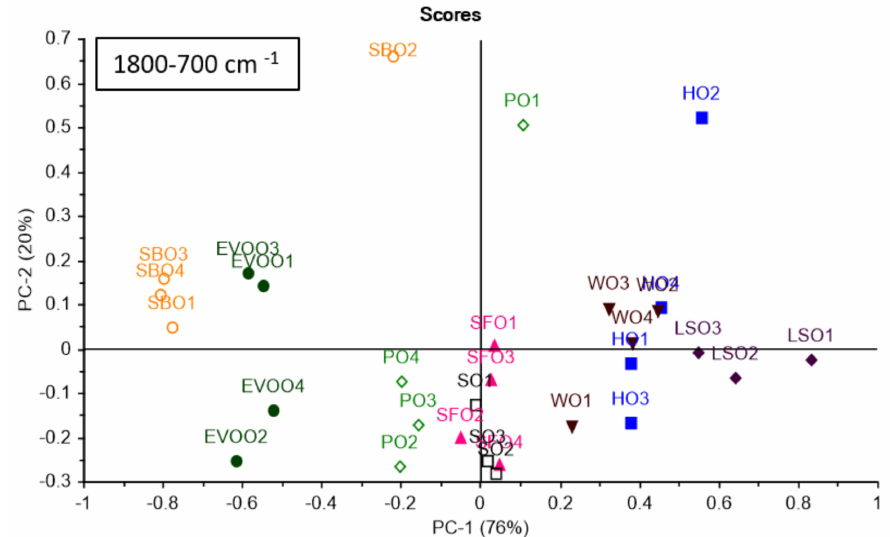
Figure 3. PCA scores for the oils’ classification using Unscrambler software. Classification based on the peak region 1800–700 cm − 1